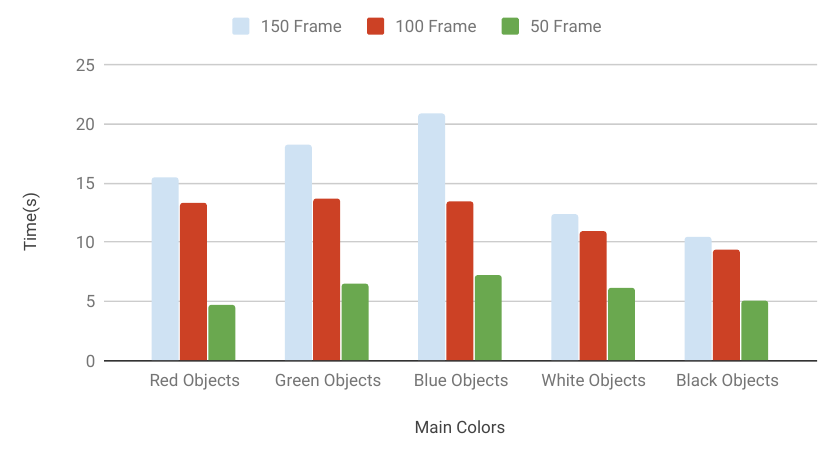
Figure 9. Average object detection time vs. number of frames.